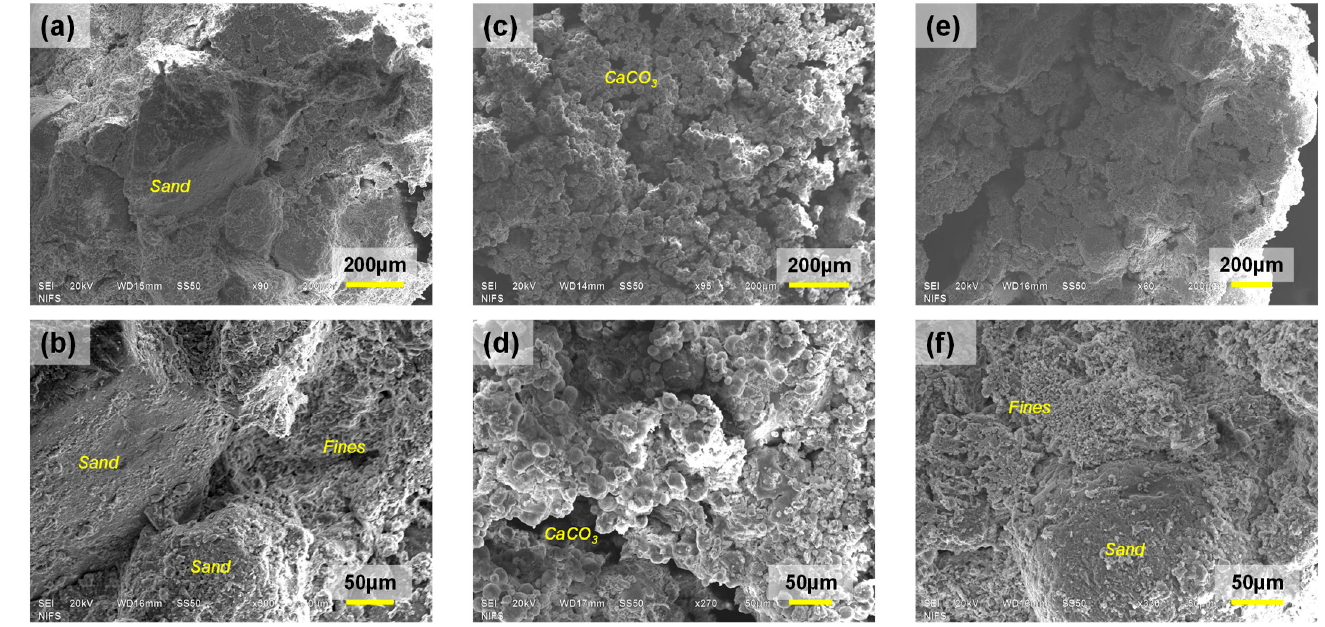
Figure 9. SEM images: ( a , b ) 1:1:1 untreated sample, ( c , d ) 1:3:0 sample tri–treated by 1 M MICP solution and surface spraying method, and ( e , f ) 1:1:1 sample treated by 0.5 M MICP solution and mixing method.